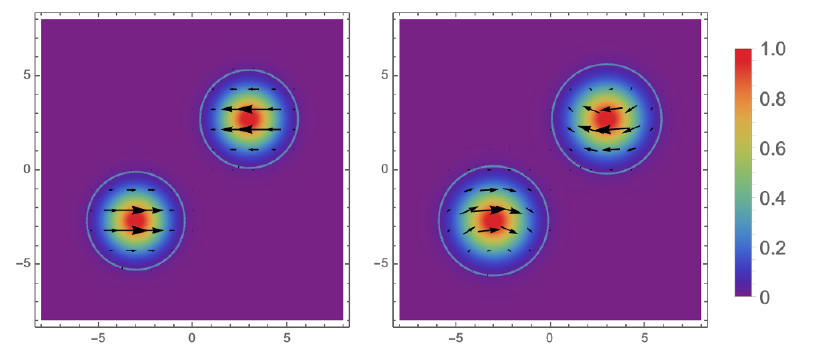
Figure 5 . Initial data for u = 1, b = 2 : 5, x 0 = 3, and a = 0 (left) and a = 0 : 5, (cid:27) = 1 (right). Here we have chosen units m 0 =